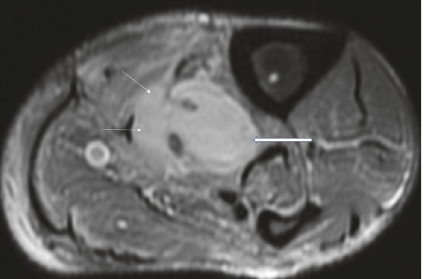
Figure 3: T2 weighted, fat saturated, postcontrast, axial MR image of left calf showing a multiloculated fluid collection with associated enhancing rim and septations (white arrows) within the tibialis posterior muscle, compatible with an intramuscular abscess.